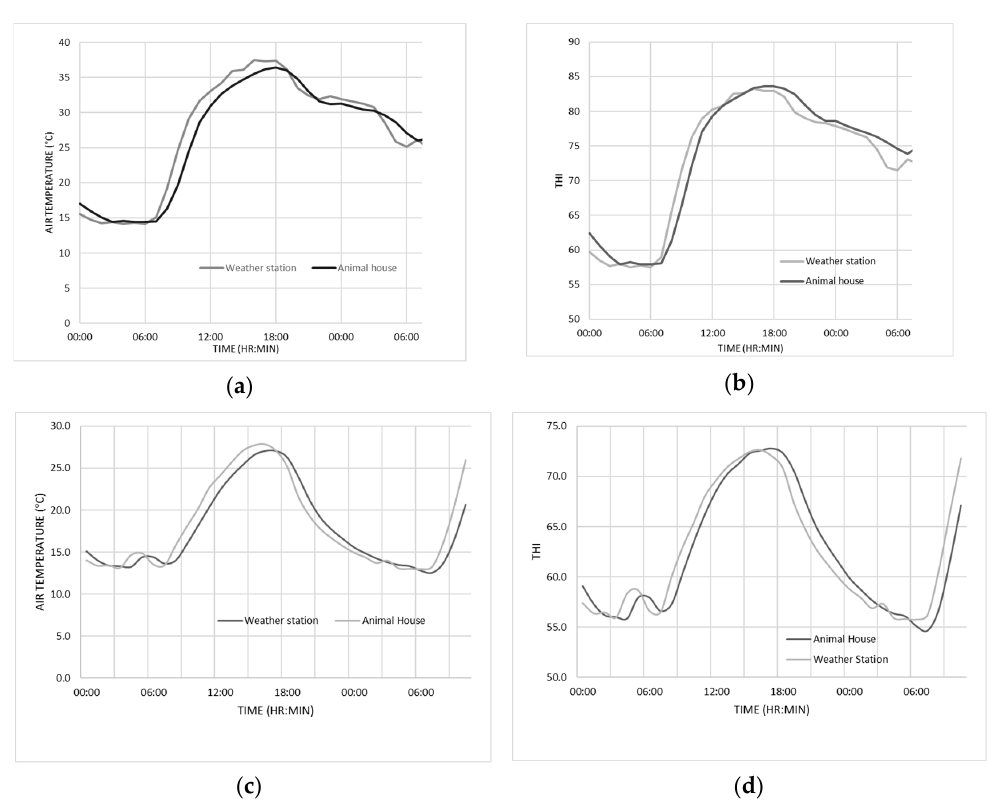
Figure 2. Comparison of air temperature and temperature-humidity index (THI) between the animal house (black line) and Hamilton, Victoria weather station (grey line) on the hottest day of the experiment (36 °C, 8 February 2017, ( a , b )) and on a day with a maximum of 27 °C, 7 March 2017, ( c , d )).